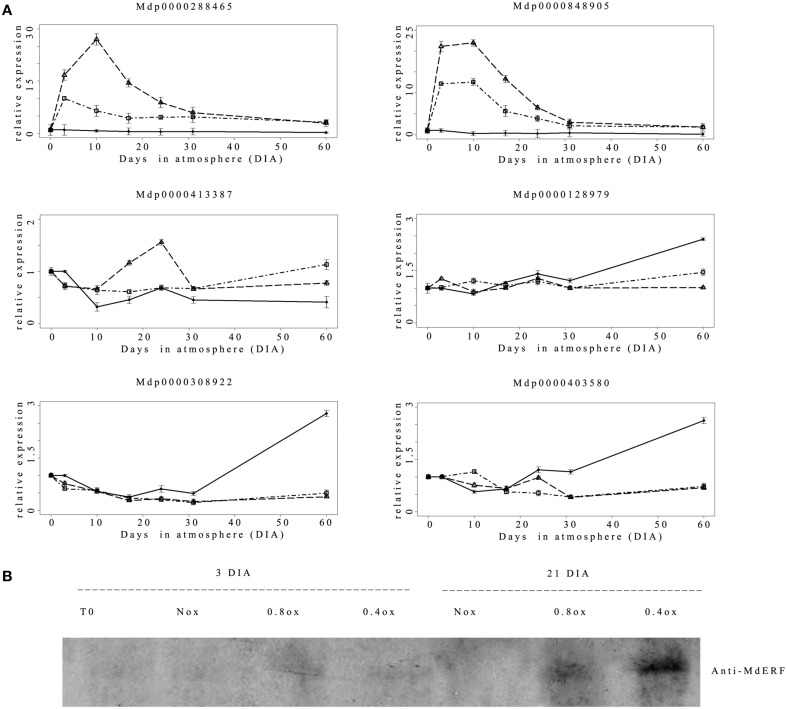
(A) Relative (T0 value = 1) expression pattern of the 6 apple class VII ERF genes. ♦ = Nox; Δ = 0.4ox; □ = 0.8ox. Data are means of three biological replicates. Error bars represent 95% confidence intervals. For 0.4ox samples 31 DIA corresponds to 1 day after the shift from 0.4 to 0.8 kPa oxygen. (B) Western blot analysis of apple class VII ERFs protein abundance carried out with specific antibodies raised against MDP308922 and MDP403580. The western blot has been performed on three biological replicates with similar results.